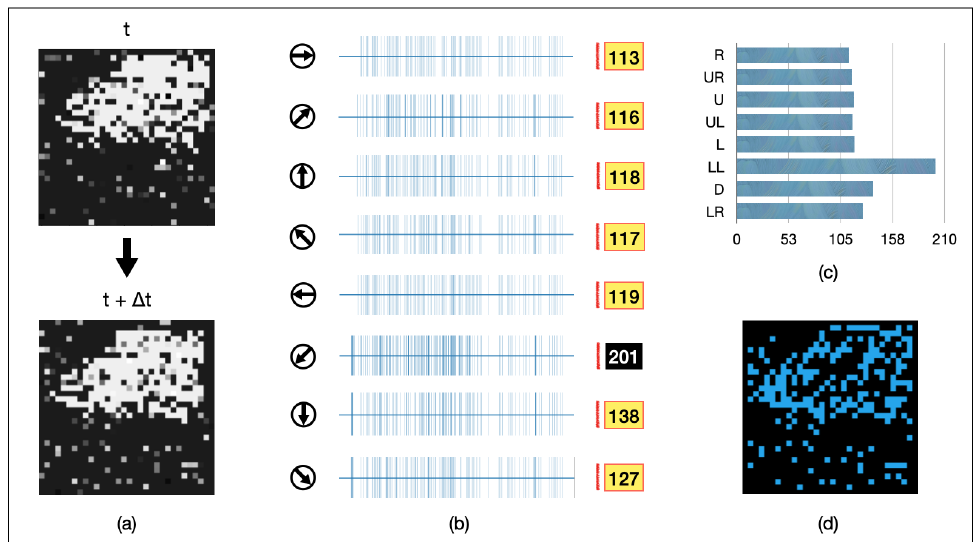
Figure 14. An AVS motion direction detection instance in dynamic full-image noise: ( a ) two successive frames of a lower leftward motion of an 256-pixel object; ( b ) activation map of the eight LMDNs during scan; ( c ) LMDNs activations are counted by a bar chart; ( d ) activated pixels by all the LMDNs during detection process are marked by blue.